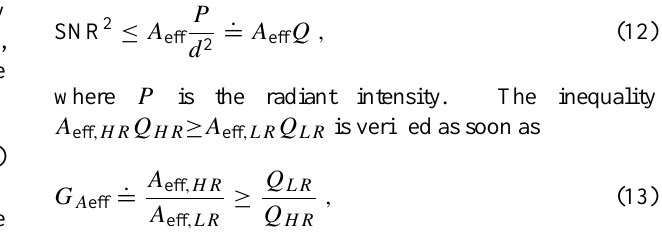
penalized by a factor N since SNR 2 = SNR 2 HR